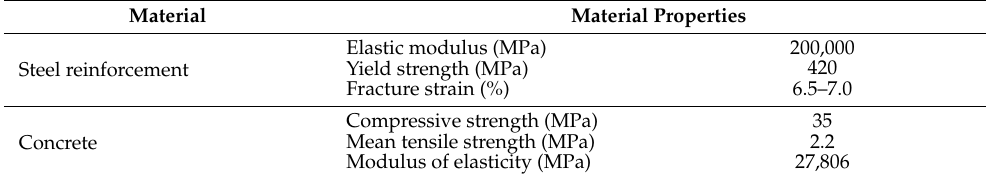
Table 2. The concrete and steel material properties used in the considered frame